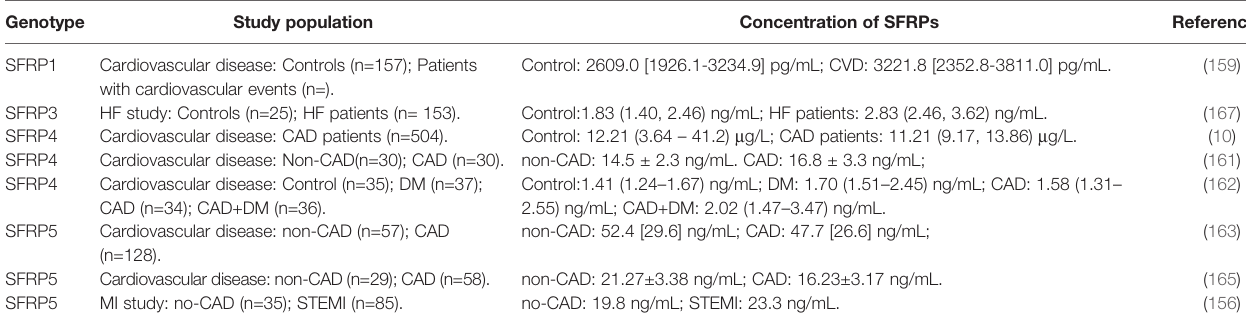
TABLE 3 | The clinic study about the concentration of SFRPs in patients with cardiovascular disease. Genotype Study population Concentration of